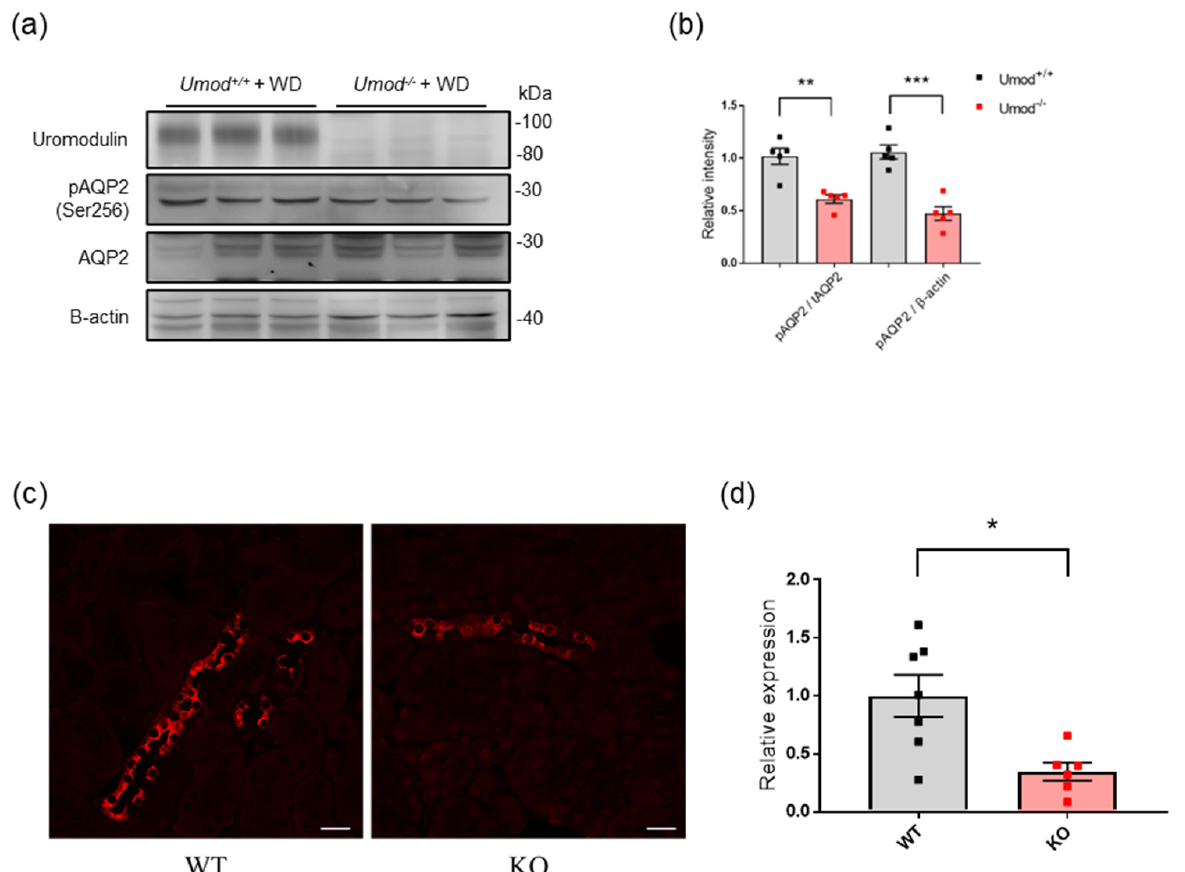
Figure 5. AQP2 activation is altered in uromodulin − deficient mice. ( a ) Western blot analysis for uromodulin, Ser256 − phosphorylated AQP2 and total AQP2 in kidney tissue from WT and Umod − KO mice after 24 h of water deprivation. β − actin was used as a loading control. ( b ) Quantification of signal intensities expressed as the ratio of phosphorylated AQP2 to total AQP2. n = 6. ** p < 0.01, *** p < 0.001 (Unpaired t − test). ( c ) Representative immunofluorescence images for Ser256 − phosphorylated AQP2 (red) in kidney sections from WT and Umod − KO mice, with strong signals in WT mouse kidney tissue. The scale bar indicates 20 µm. ( d ) Quantification of the ratio of phosphorylated AQP2 signal intensities to the tubular area. The analysis was based on at least three microscopic fields of tissue from each group of mice. * p < 0.05 (Unpaired t − test).